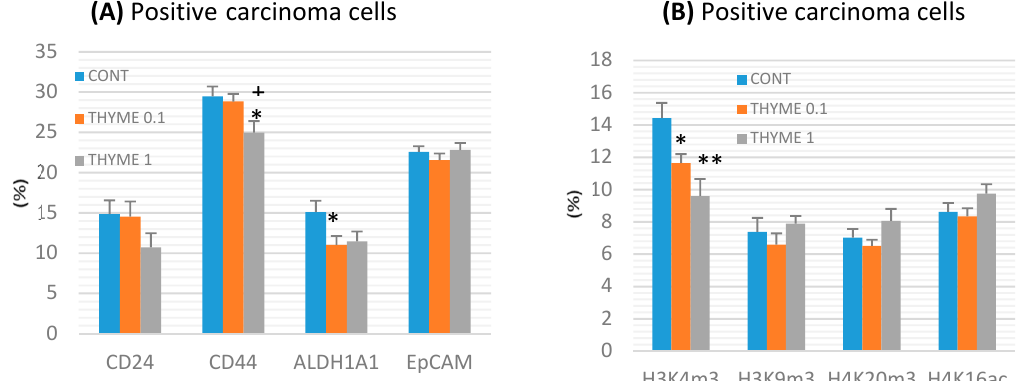
Figure 4. Immunoexpression of cancer stem-cell ( A ) and epigenome ( B ) markers in rat mammary carcinoma cells after treatment with T. vulgaris . Data are expressed as mean ± SEM. Significant difference: * p < 0.05, ** p < 0.01 versus CONT, + p < 0.05 versus THYME 0.1. The values of protein expression were compared between treated (THYME 0.1, THYME 1) and non-treated (control) carcinoma cells of female rats; at least 60 images for one marker were analyzed.